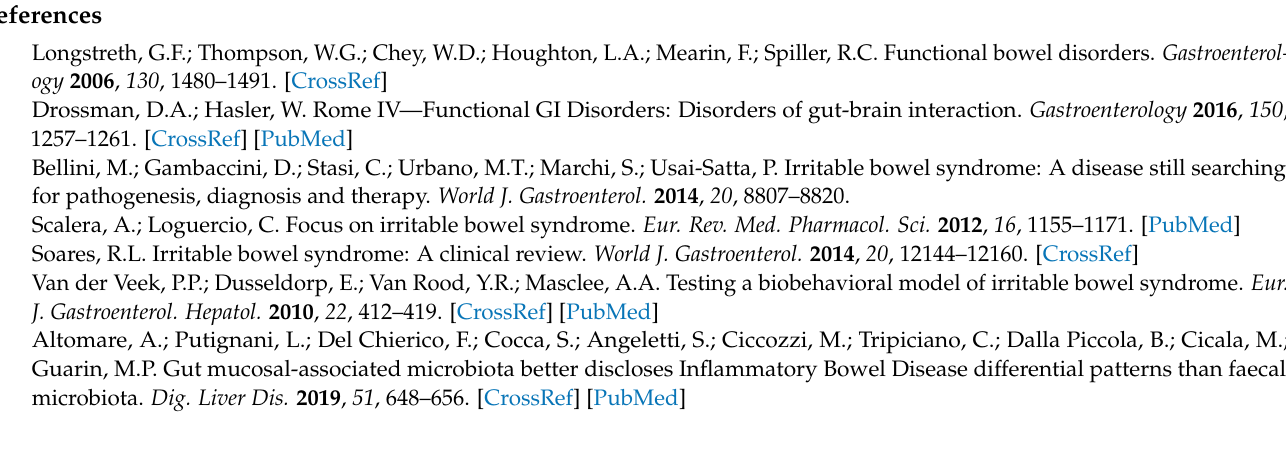
Supplementary Figure S2: Alpha and beta diversity analyses of CTRL subjects. Supplementary Figure S3: Alpha and beta diversity analyses of CTRLs vs. IBS (LARN groups). Supplementary Figure S4: Alpha and beta diversity analyses of CTRLs vs. IBS (MNs groups and non-MNs groups). Table S1: Mediterranean diet–food frequency